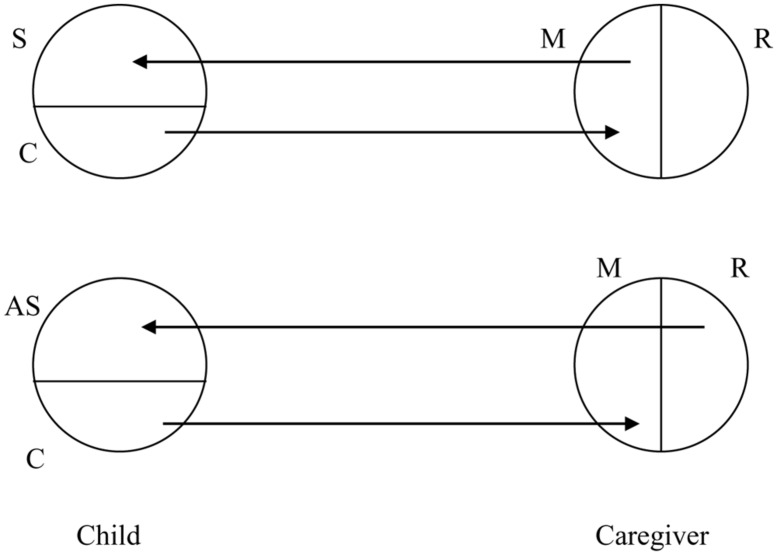
The Affect Mirroring model: in the child, secondary self-representations (“S”) of the constitutional self (“C”) are formed through the contingent mirroring self (“M”) of the parent, decoupled from his realistic self (“R”). In the case of incongruent mirroring by a realistic self-representation (“R”) of the parent, alienated secondary self-representations (“AS”) are formed in the child (Stortelder and Ploegmakers-Burg, 2010).